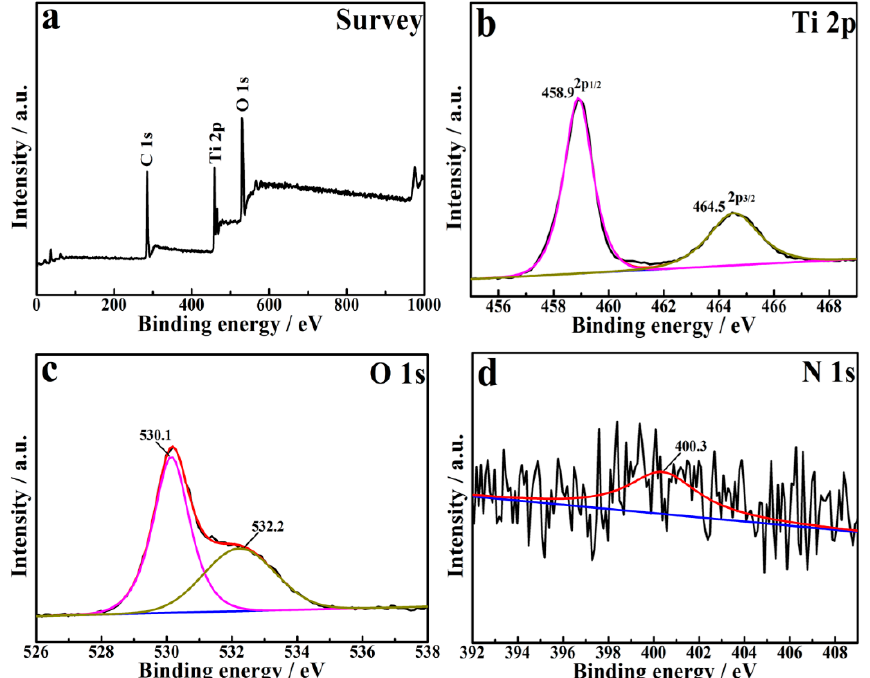
Figure 3. XPS spectra of N-TiO 2 -500: ( a ) survey spectrum; ( b ) Ti 2p ; ( c ) O 1s ; ( d ) N 1s .